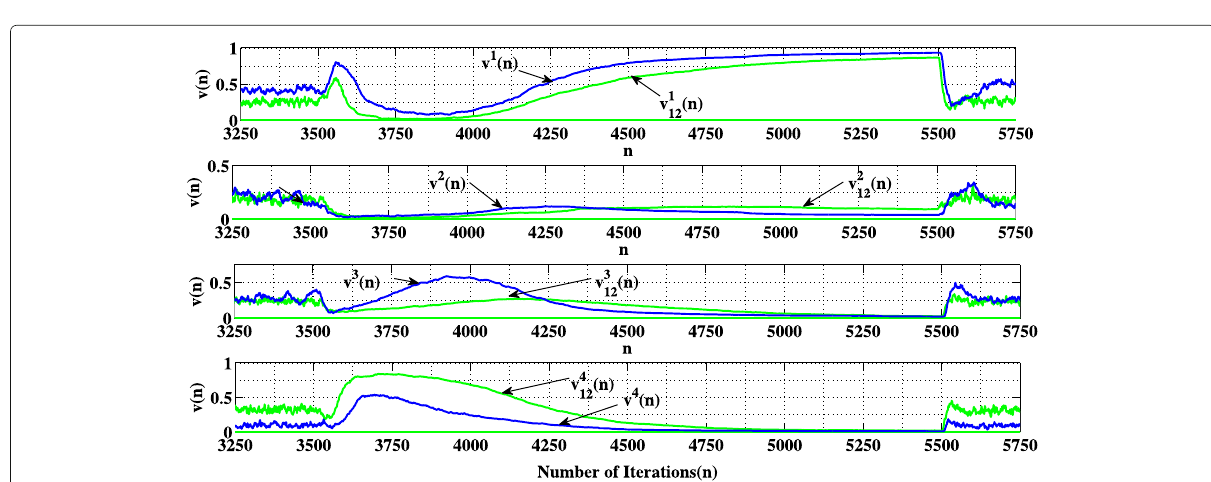
Fig. 14 Mixing coefficients vs. number of iterations ( n ) when input signal is